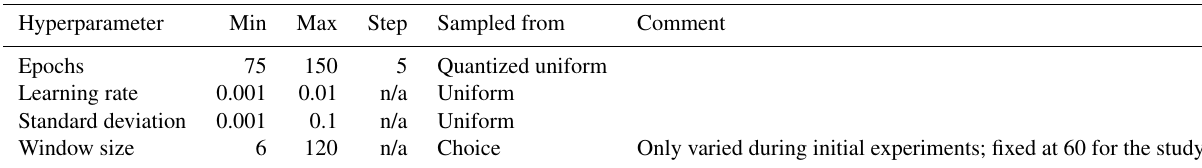
Choice Only varied during initial experiments; fixed at 60 for the study n/a means not